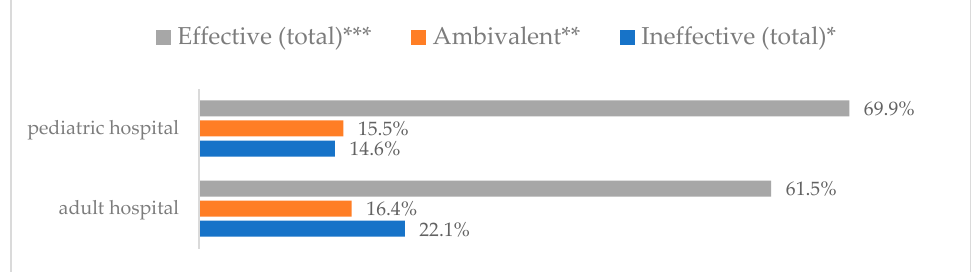
Figure 2. Wearing a protective mask that covers the mouth and nose to prevent influenza virus infection by age ( N = 905). *Sum of responses: completely ineffective, ineffective, rather ineffective; **Response: neither ineffective nor effective; ***Sum of responses: rather effective, effective, completely effective.